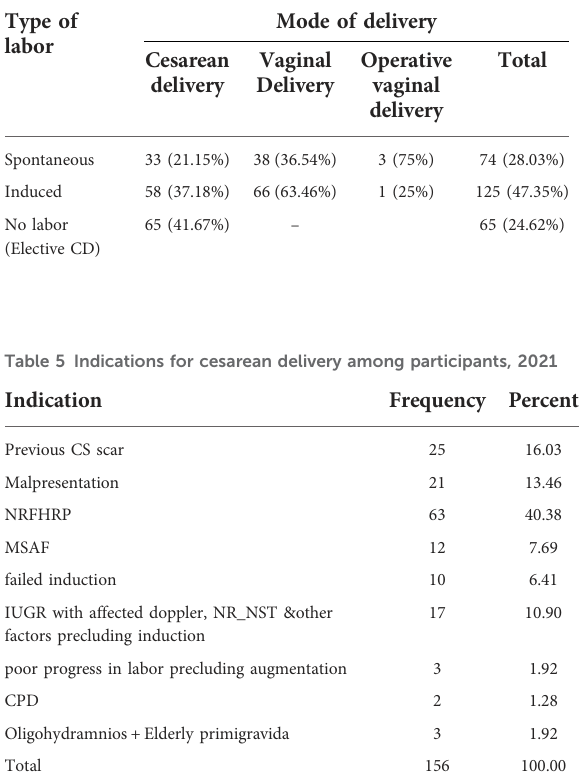
TABLE 6 Adverse perinatal outcomes of participants,